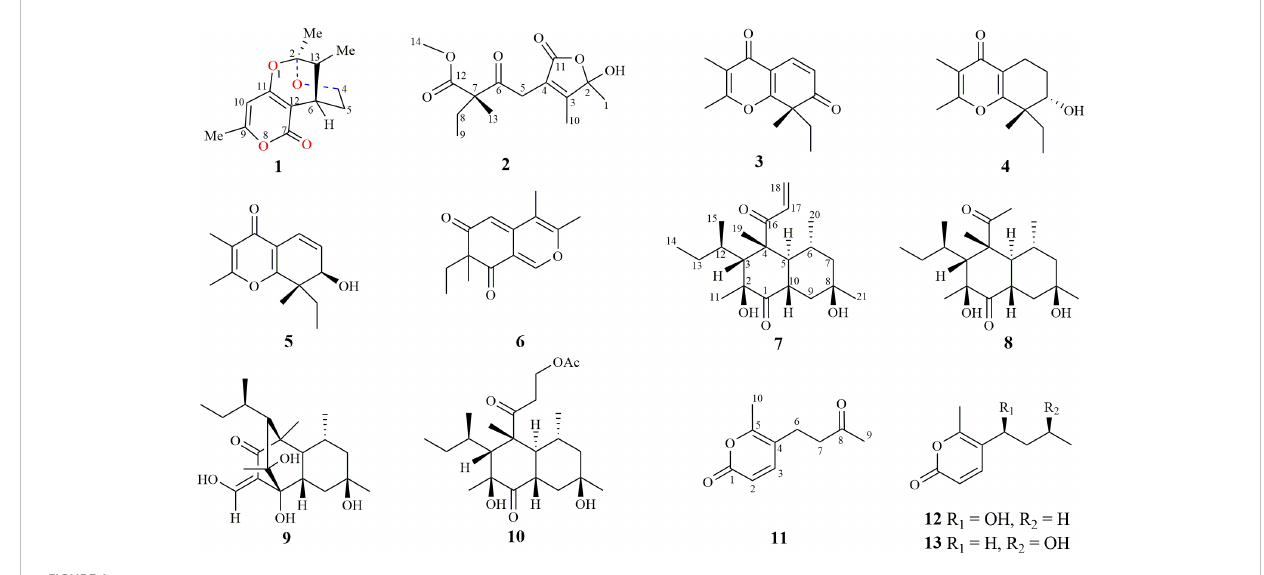
FIGURE 1 Chemical structures of compounds 1 –